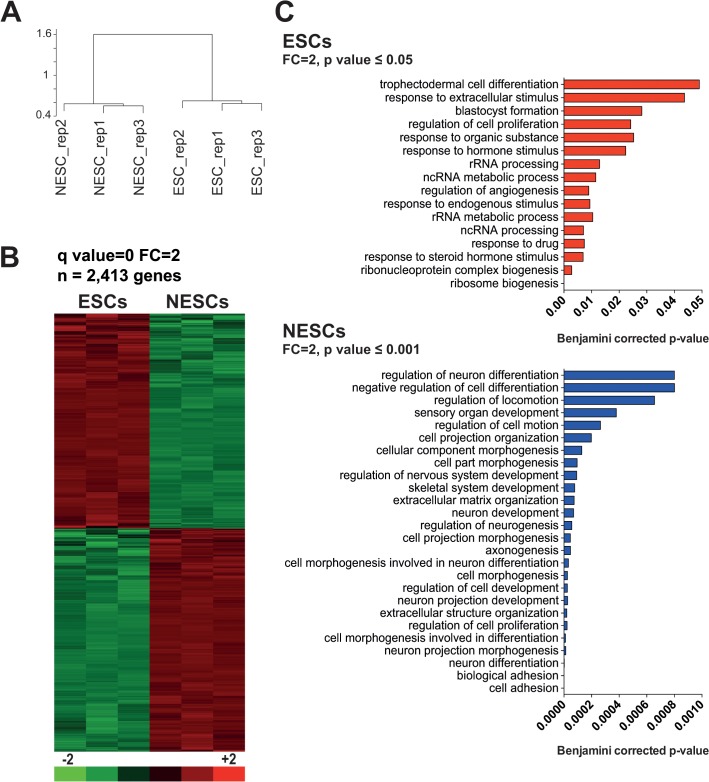
Change in gene expression profile during ESC neural induction.A) Global unsupervised clustering performed on the entire pool of 19,204 genes indicates that, at the transcriptional level, ESCs and NESCs are two distinct cell populations. Red boxes highlight reproducible clusters that are strongly supported by data (Bootstrap Probability value ≥95%). B) Heat map of the subset of 2,413 genes that change their expression levels in ESCs as compared to NESCs (at False Discovery Rate <0.01 and absolute FC level ≥2). Expression levels are presented as row-wise standardized values (log2 fold change). C) Functional enrichment of the 2,413 differentially expressed genes obtained using DAVID GO annotation. Upper plot reports the GO categories associated to genes up-regulated in ESCs, while in the lower plots are the functional enrichment of genes over-expressed during neural induction, i.e. in NESCs.